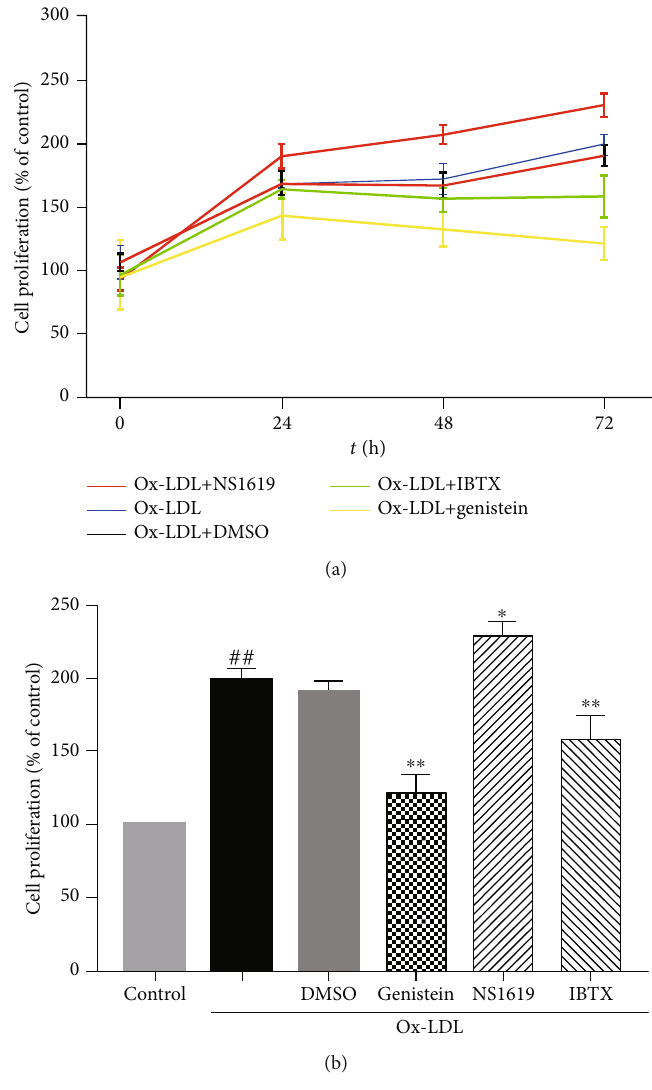
Figure 1: The e ff ect of genistein and BKCa channels on Ox-LDL-induced VSMC proliferation. Cell proliferation was determined by CCK-8. (a) Cell proliferation curves of di ff erent treatments. (b) The cell proliferation rate of di ff erent groups at 72h. Ox-LDL increases the proliferation of primary cultured VSMCs. Genistein and IBTX inhibit Ox-LDL-increased proliferation, while NS1619 increases proliferation. DMSO had no signi fi cant e ff ect. Results were presented as the mean ± SD from three independent experiments. ## P < 0 : 01 vs. control, ∗ P < 0 : 05 and ∗∗ P < 0 : 01 vs.